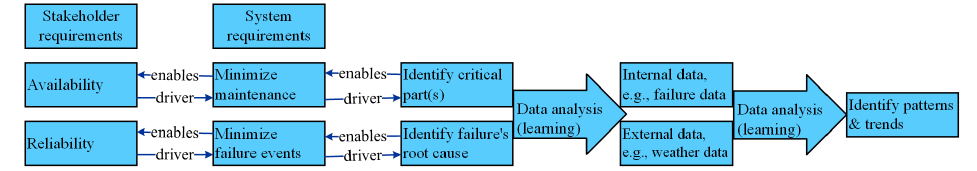
Figure 6. Business and customer Key Drivers .